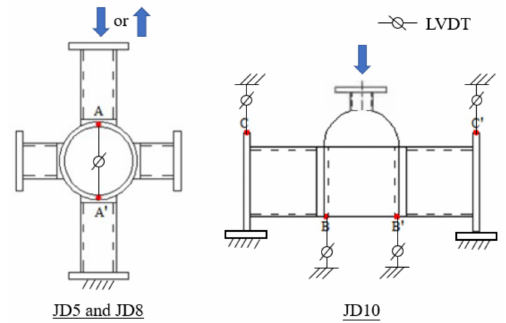
Figure 4. Loading conditions and layout of LVDTs for tested specimens.